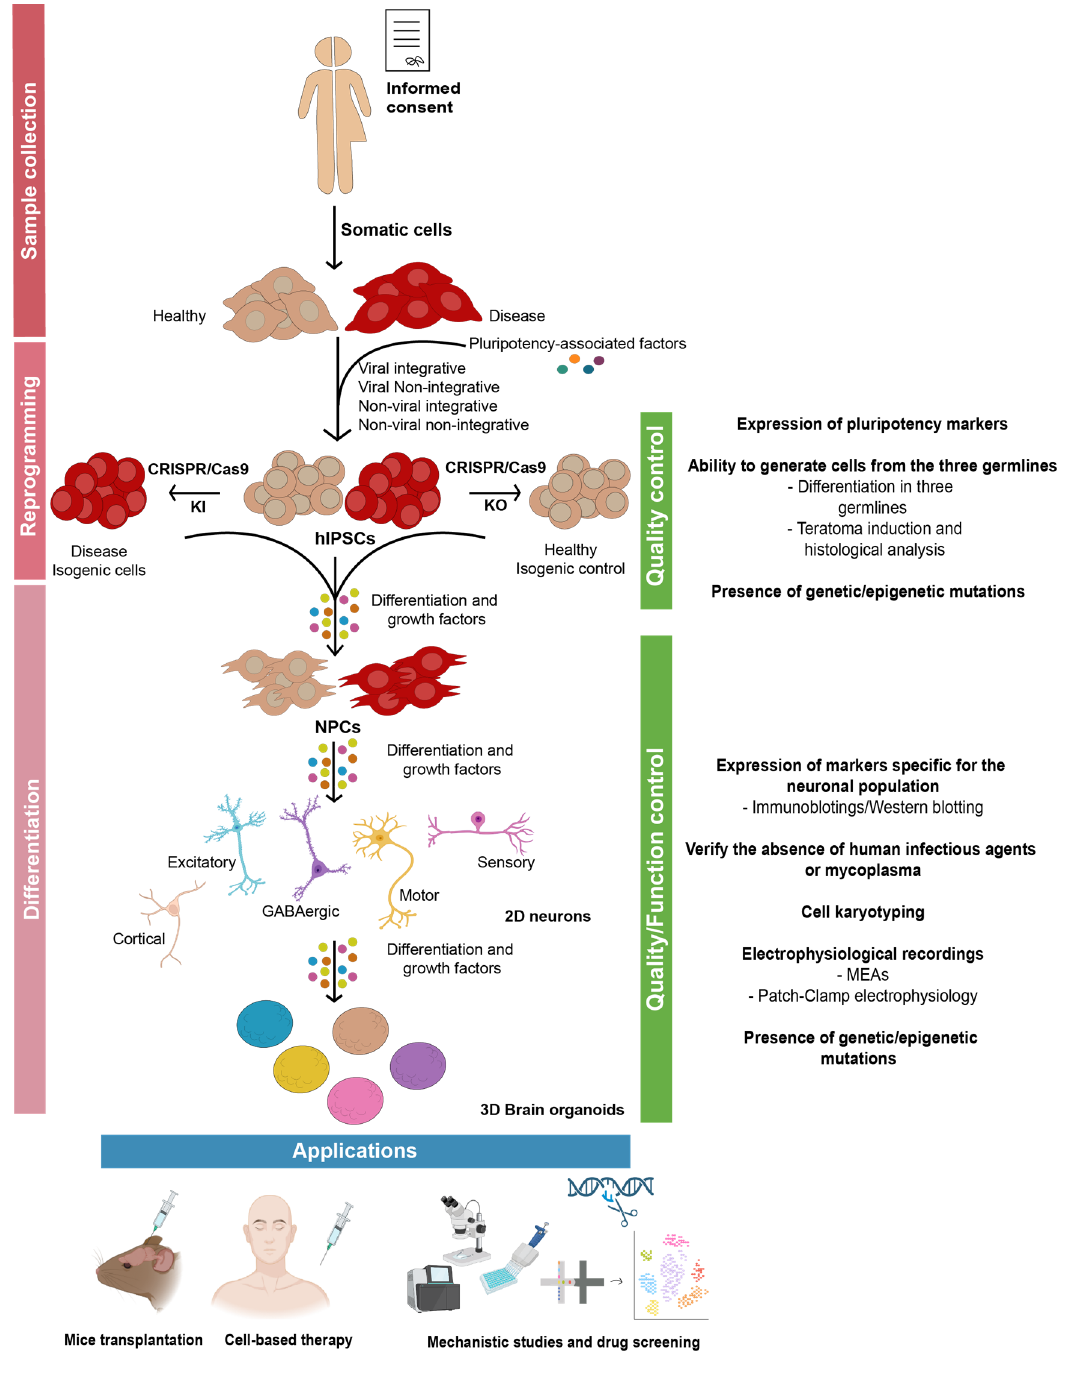
Figure 2. hIPSC generation and applications. Sample collection of somatic cells can only be performed after the patient signs the informed consent. Reprogramming of healthy/disease cells into hIPSCs happens through the delivery of pluripotency-associated transcription factors. After hIPSC generation, these may be genetically modified using CRISPR/Cas9 to generate healthy/disease isogenic cells. Before differentiation into neuronal cultures, quality control techniques should be applied to ensure the pluripotency and genomic integrity of the obtained cells. Next, different neuronal populations may be obtained through the addition of differentiation and growth factors to the culture medium. Again, quality of the cells and their functional properties should be assessed throughout this step. Finally, hIPSCs may be used for mechanistic studies, target identification and drug screenings, for transplantation into rodent models or, ultimately, for cell-based therapies.